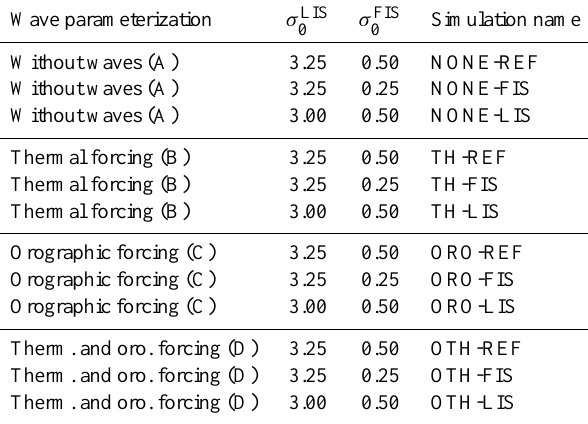
Table 1. Experimental set-up. For each experiment, the 1st part of the name (NONE, TH, ORO, OTH) corresponds to the stationary wave parameterization while the second part corresponds to the ab- lation formulation: REF indicates the couple σ LIS baseline experiment, FIS correspond to a PDD parameterization fa- voring the growth of Fennoscandian ice sheet, and LIS to a PDD parameterization favoring the growth of Laurentide ice